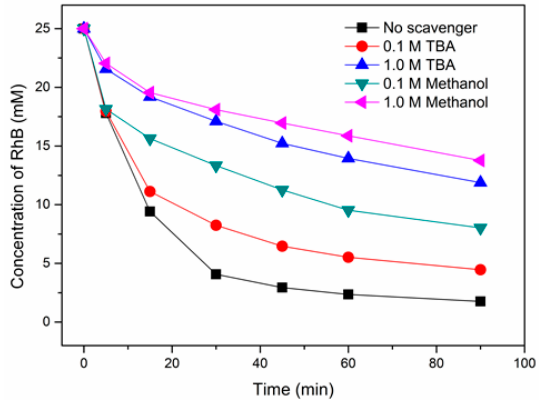
Figure 9. Inhibition effect of radical scavengers on RhB degradation in the presence of HA at pH 5. Concentrations: [Sch] = 0.5 g/L, [RhB] = 25 mM, [PS] = 5 mM, [HA] = 0.5 mM, [TBA] = 0–1 mM, and [Methanol] = 0–1 mM.